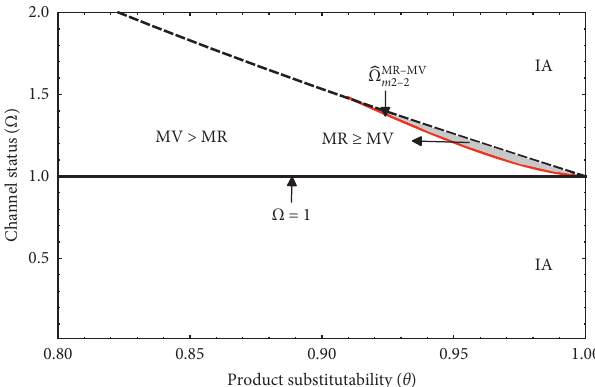
Figure 6: Comparison of manufacturer 2 profits under MS.